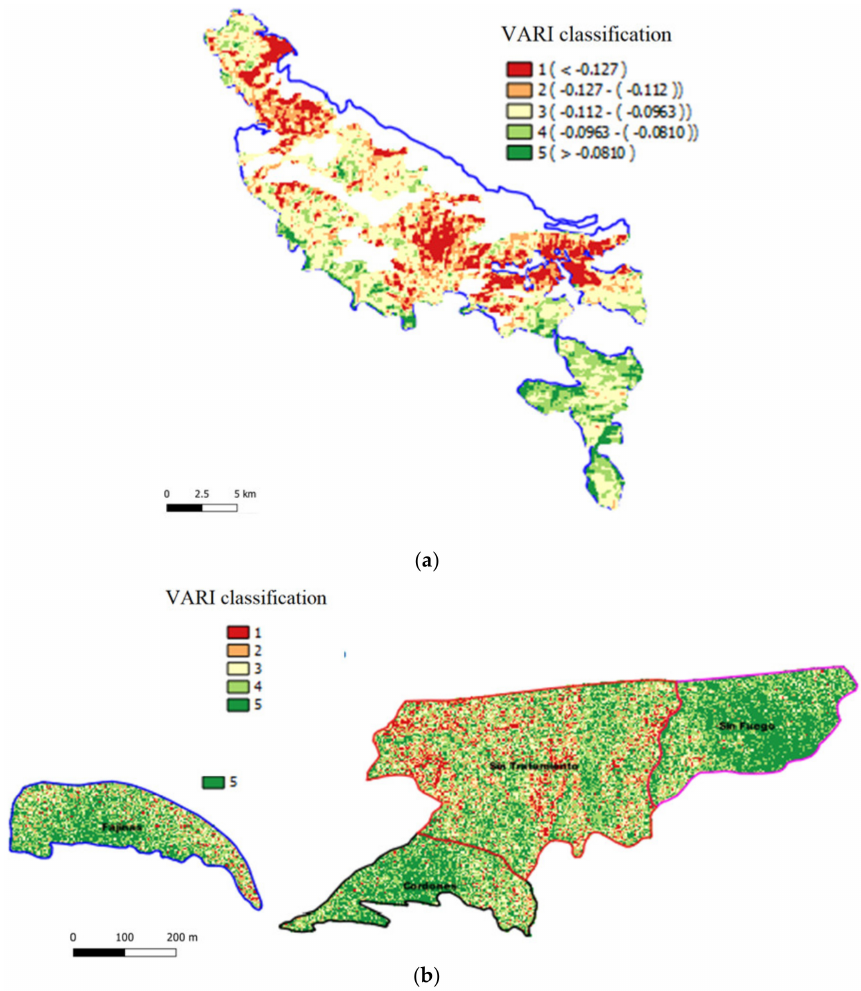
Figure 6. Spatial distribution of VARI surveyed by satellite ( a ) and UAV ( b ) images of 2016 among four land conditions after the wildfire of 2012 in Sierra de Los Donceles forest (Castilla-La Mancha, Spain). Legend: Fajinas = log erosion barriers; cordones = contour-felled log debris; sin tratamiento = burned and no Action; sin fuego =